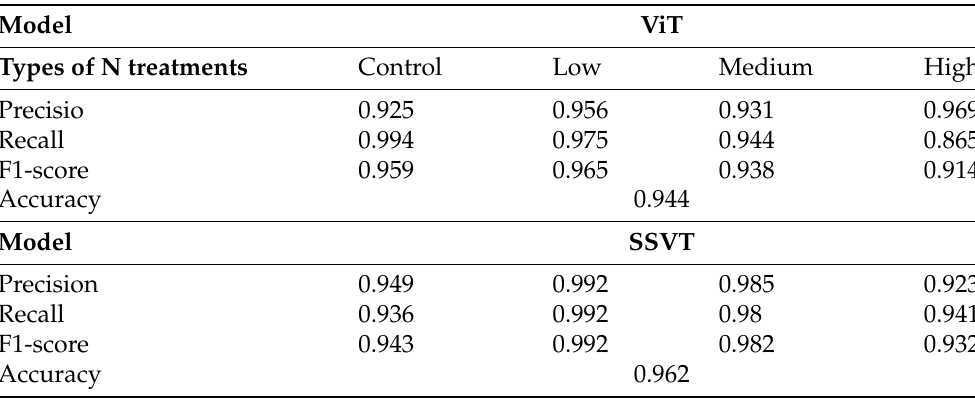
Table 7. Model performance comparison with the proposed model with SBA and the original ViT (four types of N treatment: Control, Low, Medium, and